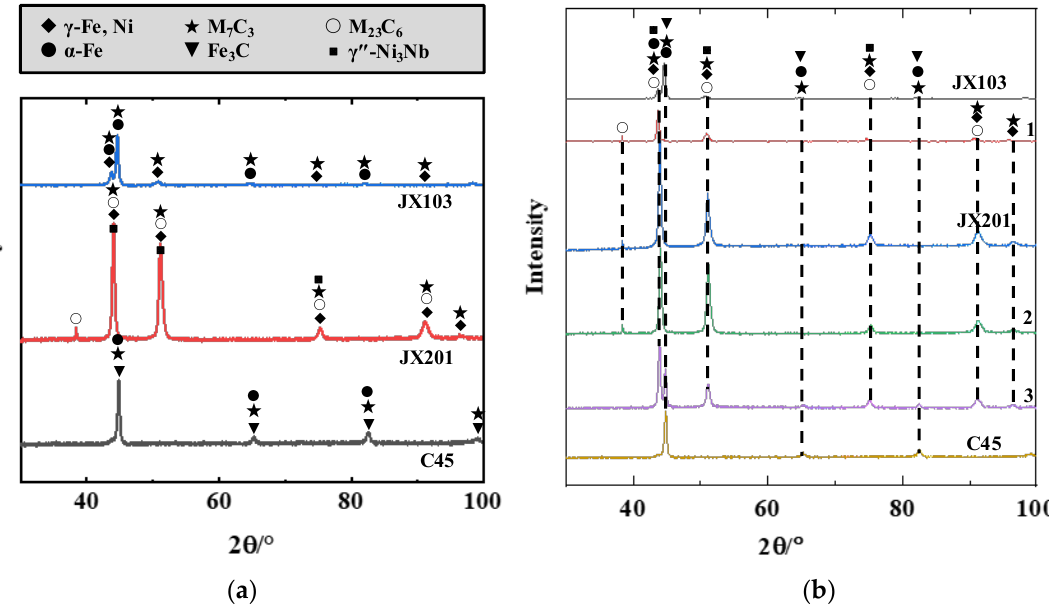
Figure 6. XRD analysis result of the welded materials at six different positions (along the building direction). ( a ) XRD results of C45 and welded materials of JX201 and JX103; ( b ) XRD results of the three materials and the fusion boundaries in between.